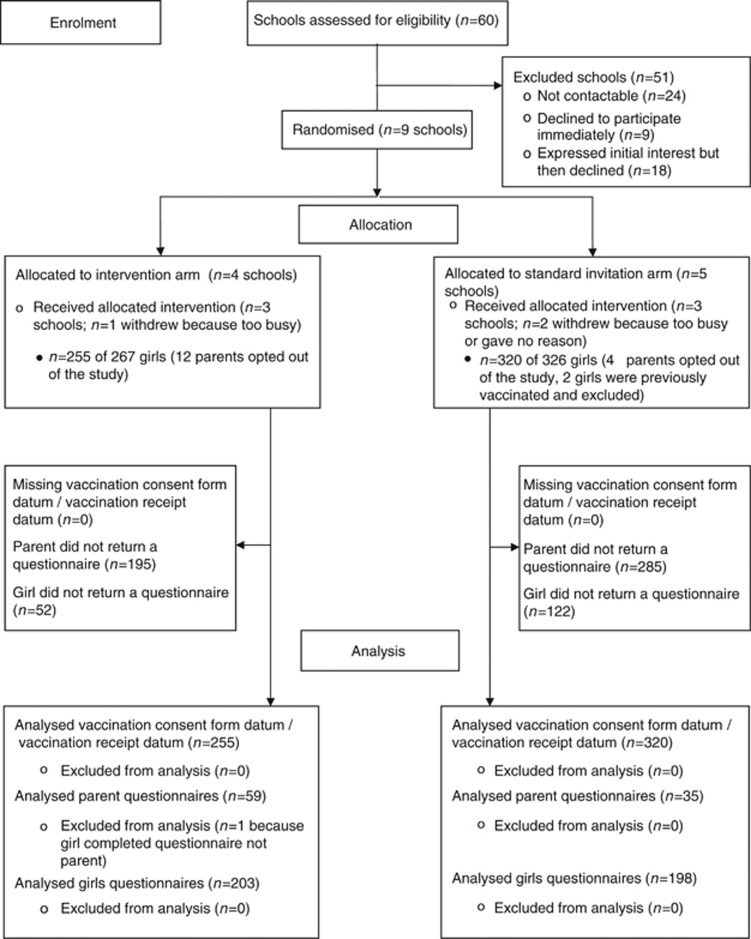
Trial flow diagram.